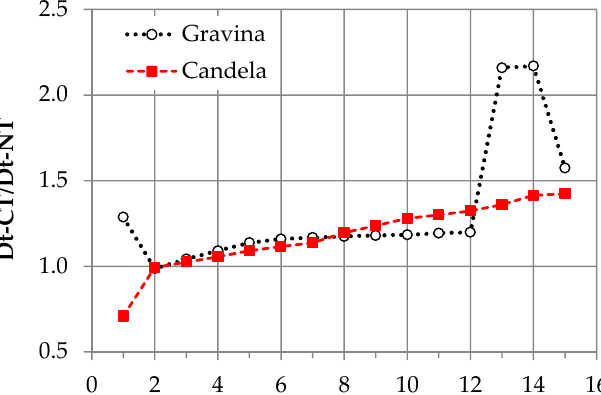
Figure 3. Ratio between the mean infiltration time for water infiltration in CT and NT during the Beerkan runs against the number of the applied volumes of water.